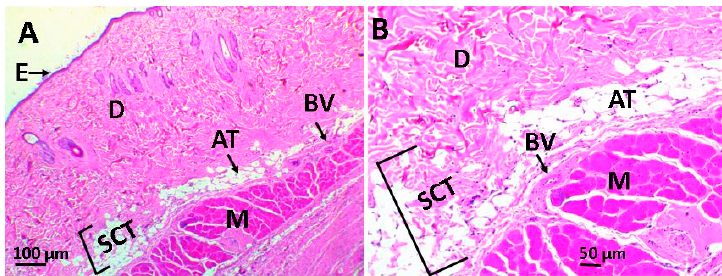
Figure 6. The dorsal area of the rat Wistar after 30 days of the implantation: ( A ) hair recovery, ( B ) absence of injuries and infections, and ( C ) internal surface of the skin where the implanted samples are encapsulated by scar tissue.